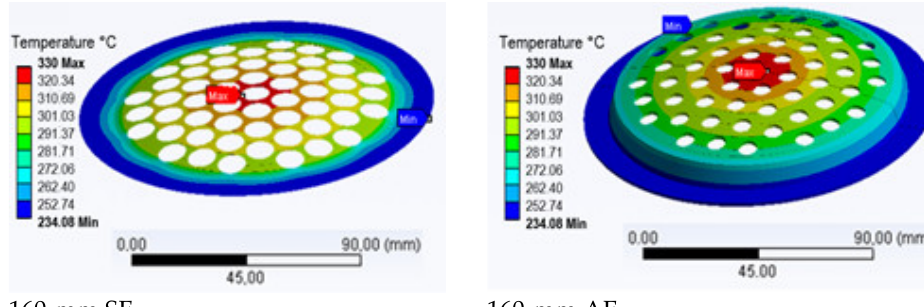
Figure 16. Element-by-element partition of electrodes in the ANSYS software—mesh model devel- opment.